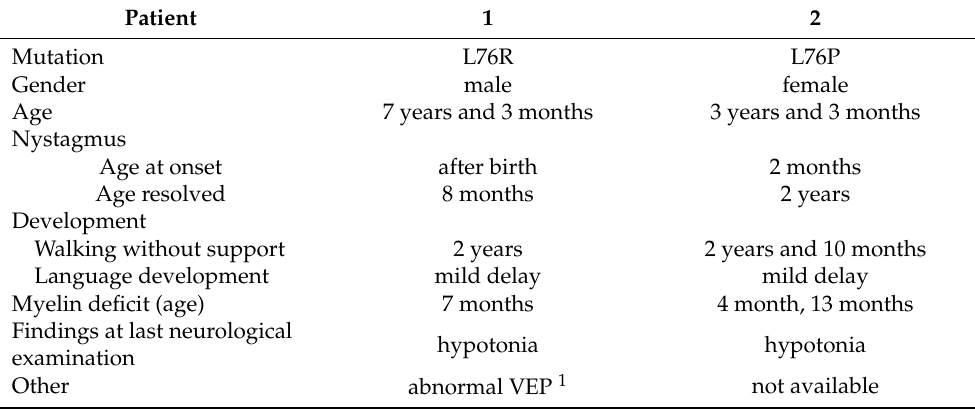
Table 1. Clinical characteristics of two patients with variants in TMEM163